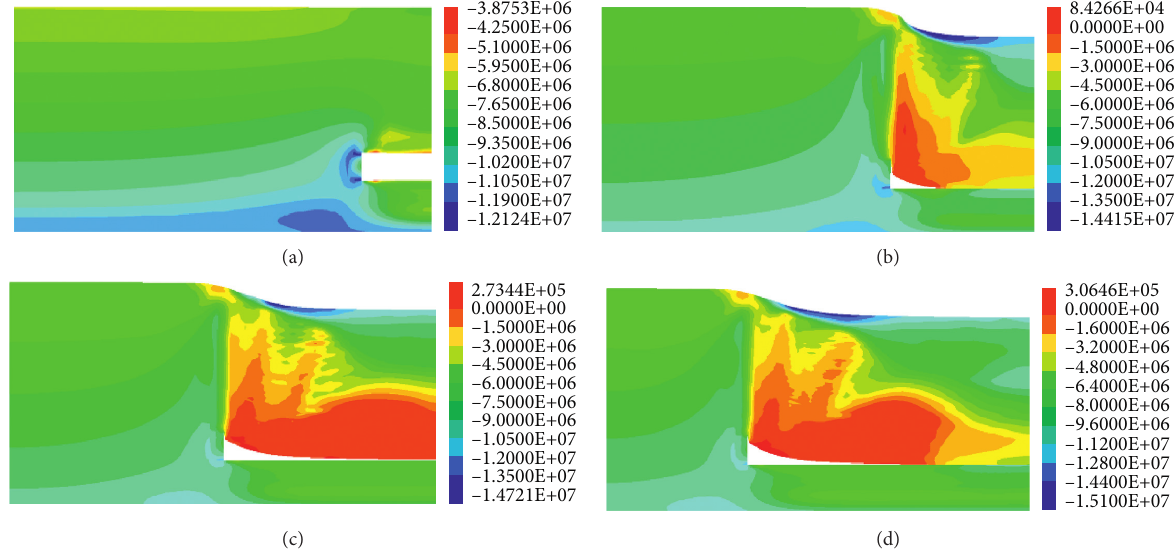
Figure 20: Horizontal stress distribution of strike surrounding rock with different advancing distances. (a) Advance 50 m. (b) Advance 100m. (c) Advance 150m. (d) Advance 200m.